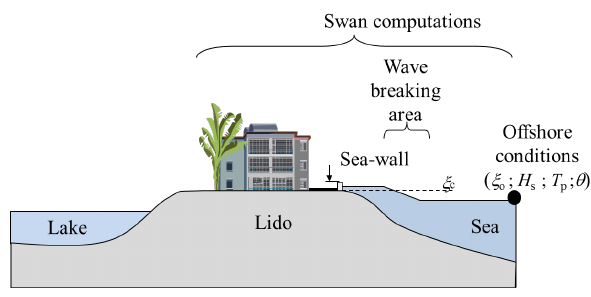
Figure 3. Schematic cross shore representation of the processes accounted for in the SWAN 3 Fig. 3. Schematic cross shore representation of the processes ac- models for the idealized study site. 4 counted for in the SWAN models for the idealized study